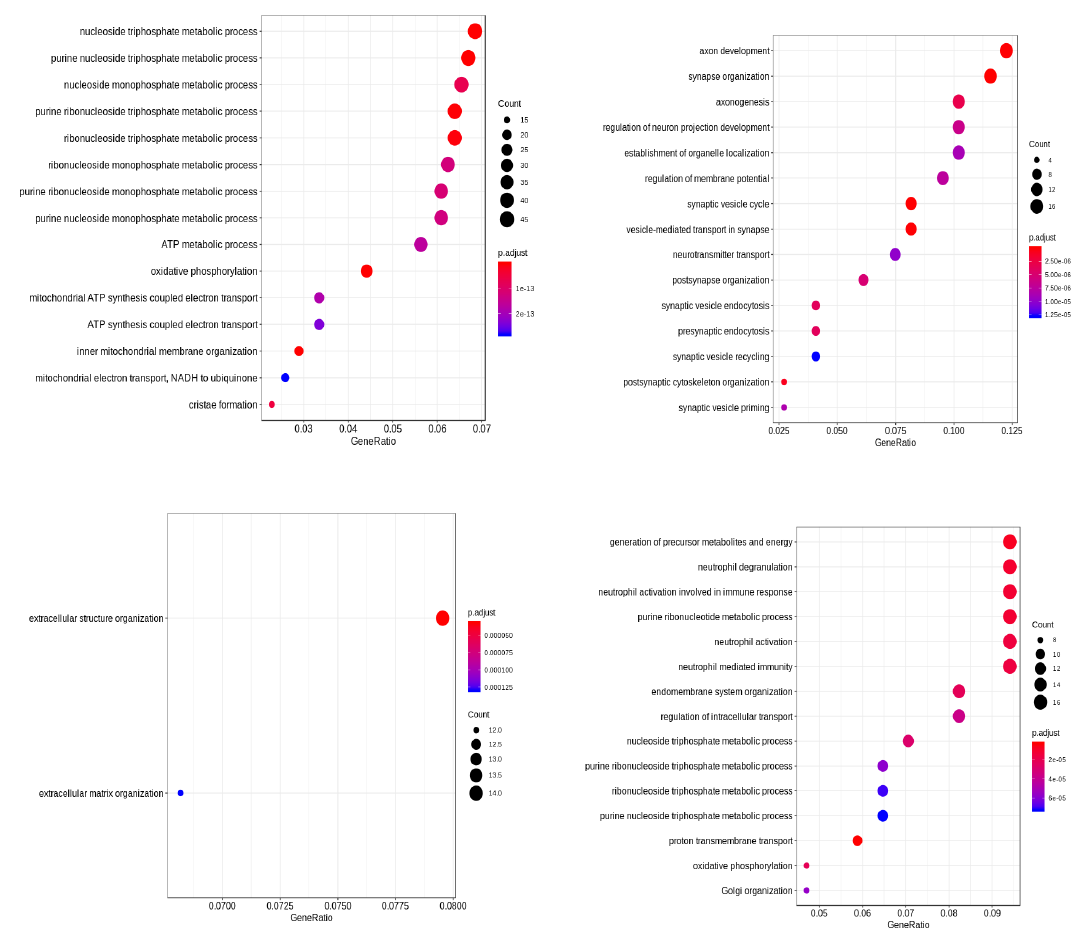
Figure 6. Functional analysis of genes in the different clusters of